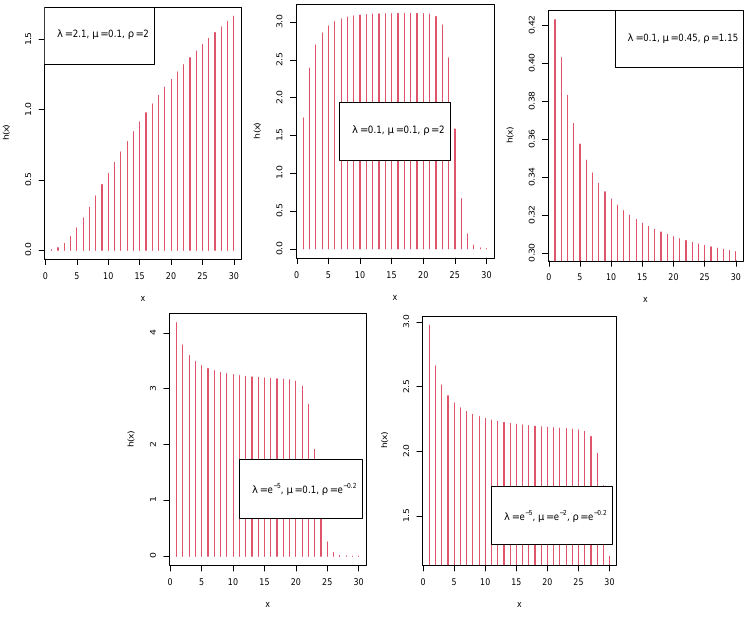
Figure 4. Plots of the HRF of the LIPD